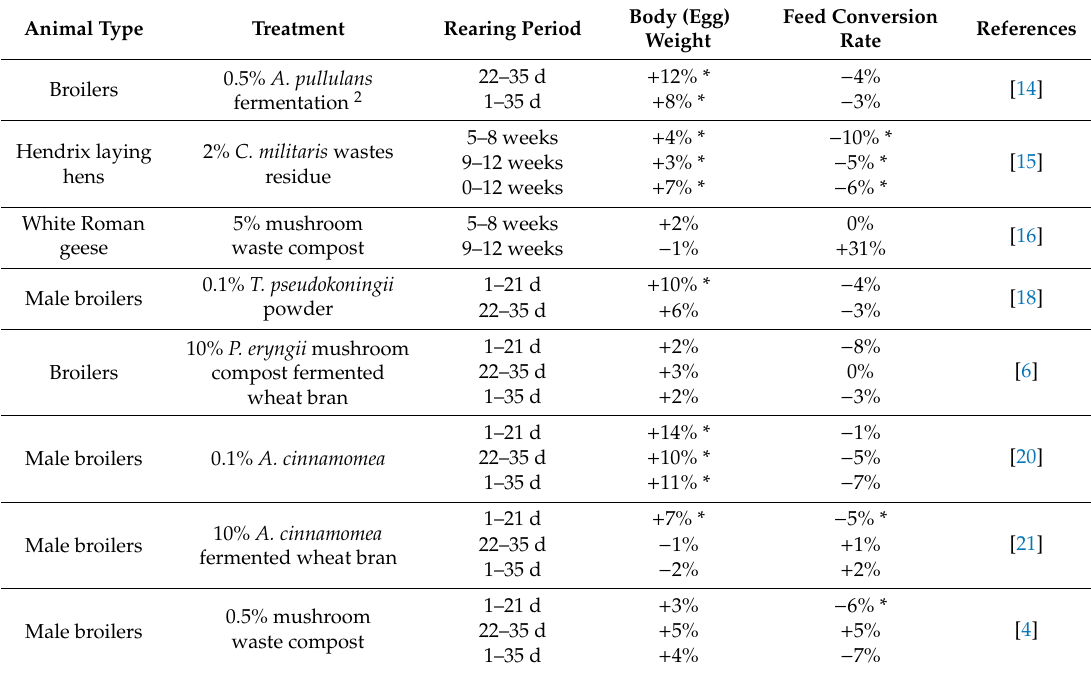
Table 1. The e ff ects of fungal feed additives on animal growth 1